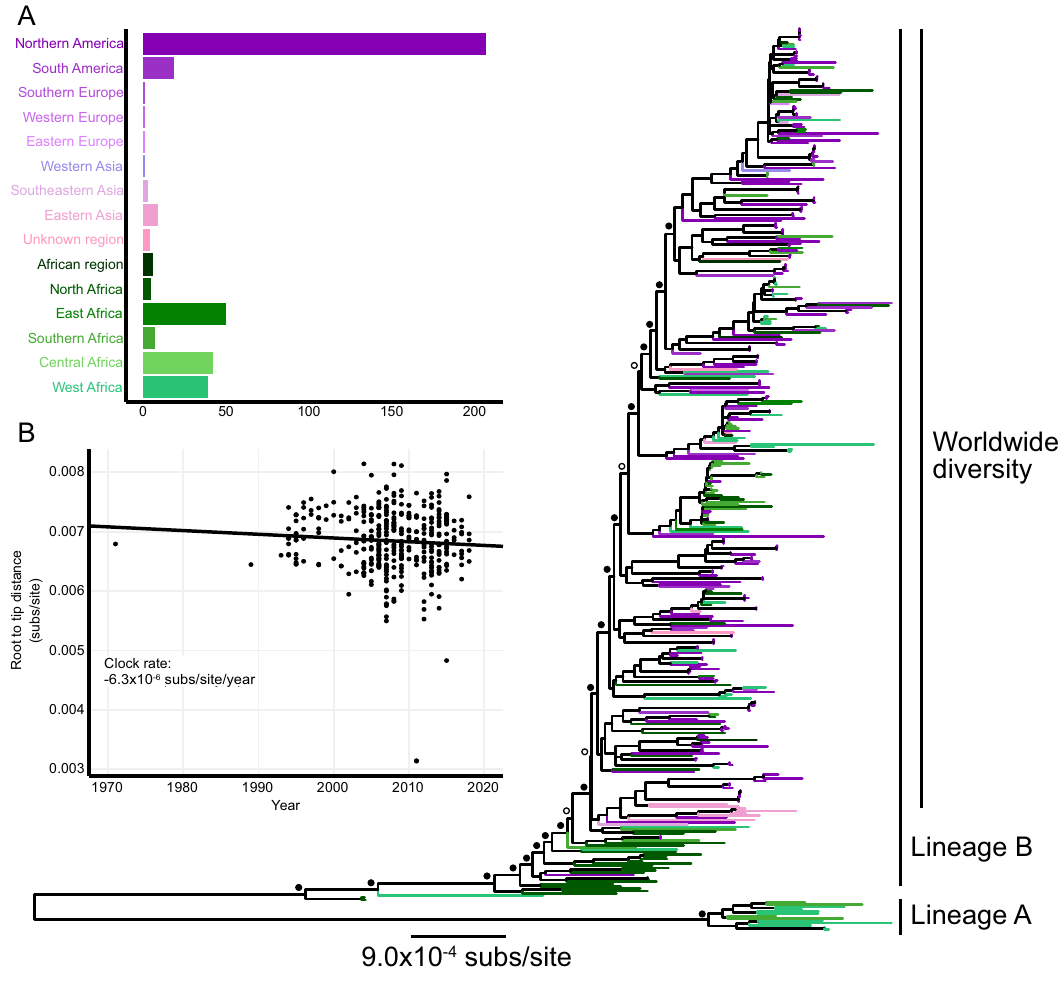
Fig.1|MaximumlikelihoodphylogeneticanalysisofempiricalHSV-2genomes. A HSV-2 dataset of 395 sequences by number of samples from each region. B Maximum likelihood phylogenetic tree inferred under a GTR + F+R4 model.